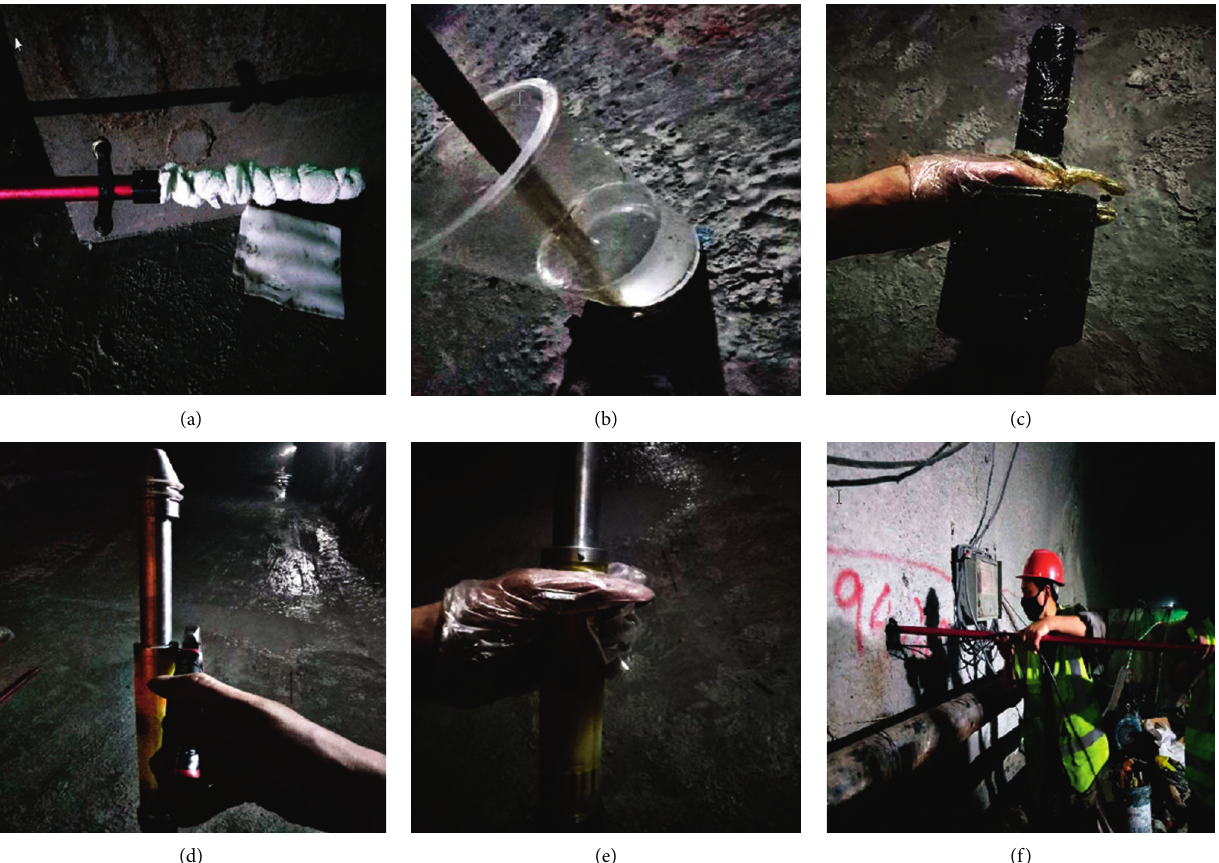
Figure 2: Stress gauge installation process. (a) Prepare to clean the hole. (b) Mixing glue. (c) Apply butter. (d) Insert pin. (e) Apply glue. (f) Place the stress